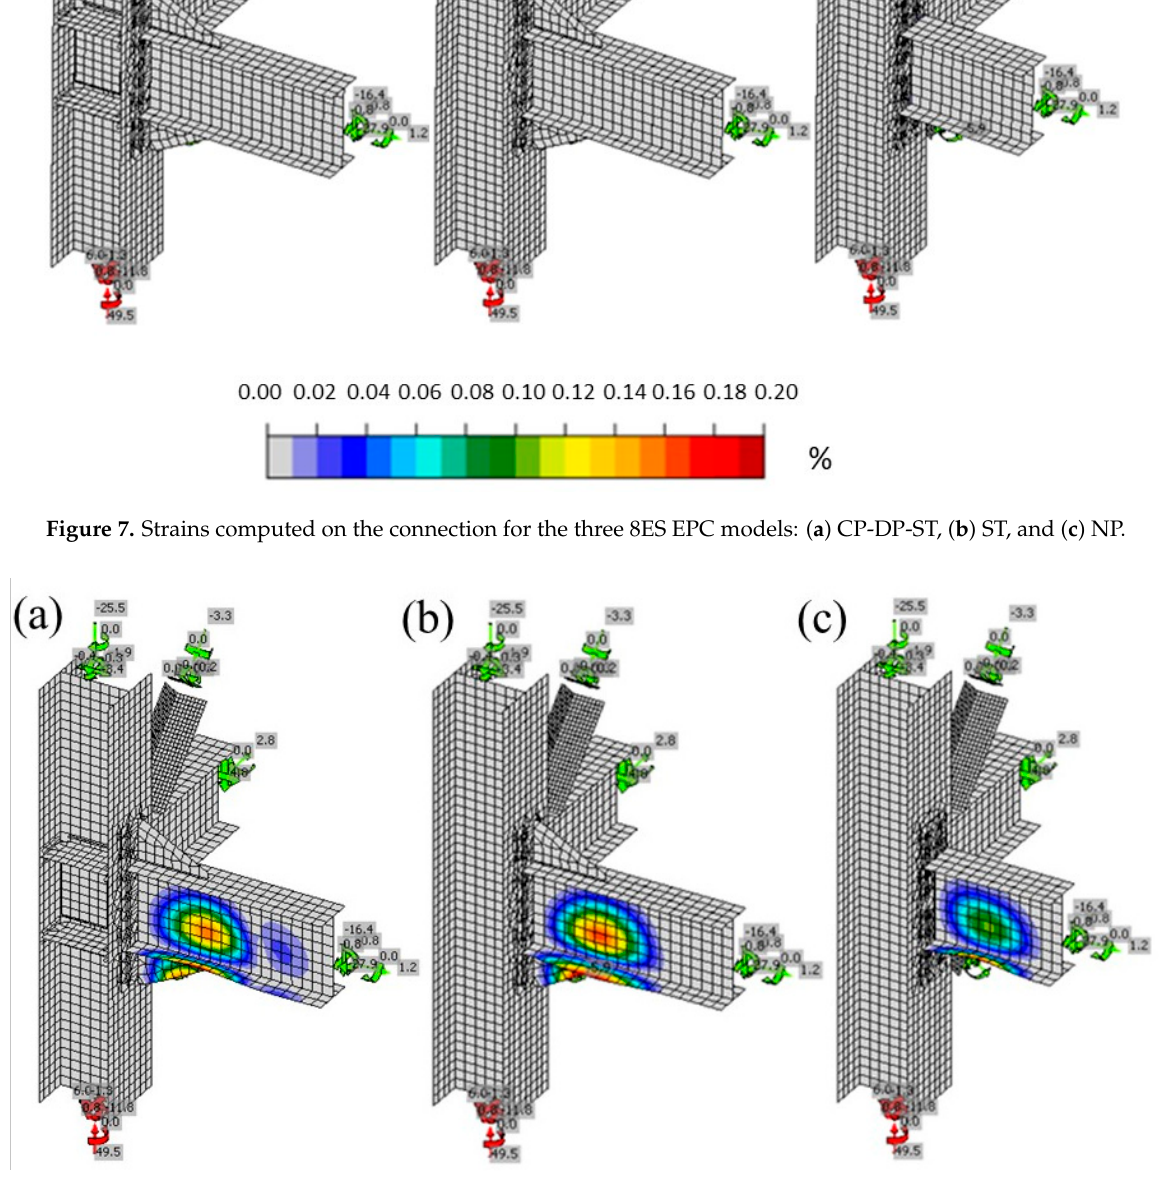
Figure 8. Local bucking modes computed on the connection for the three 8ES EPC models: ( a ) CP-DP-ST, ( b ) ST, and ( c ) NP.